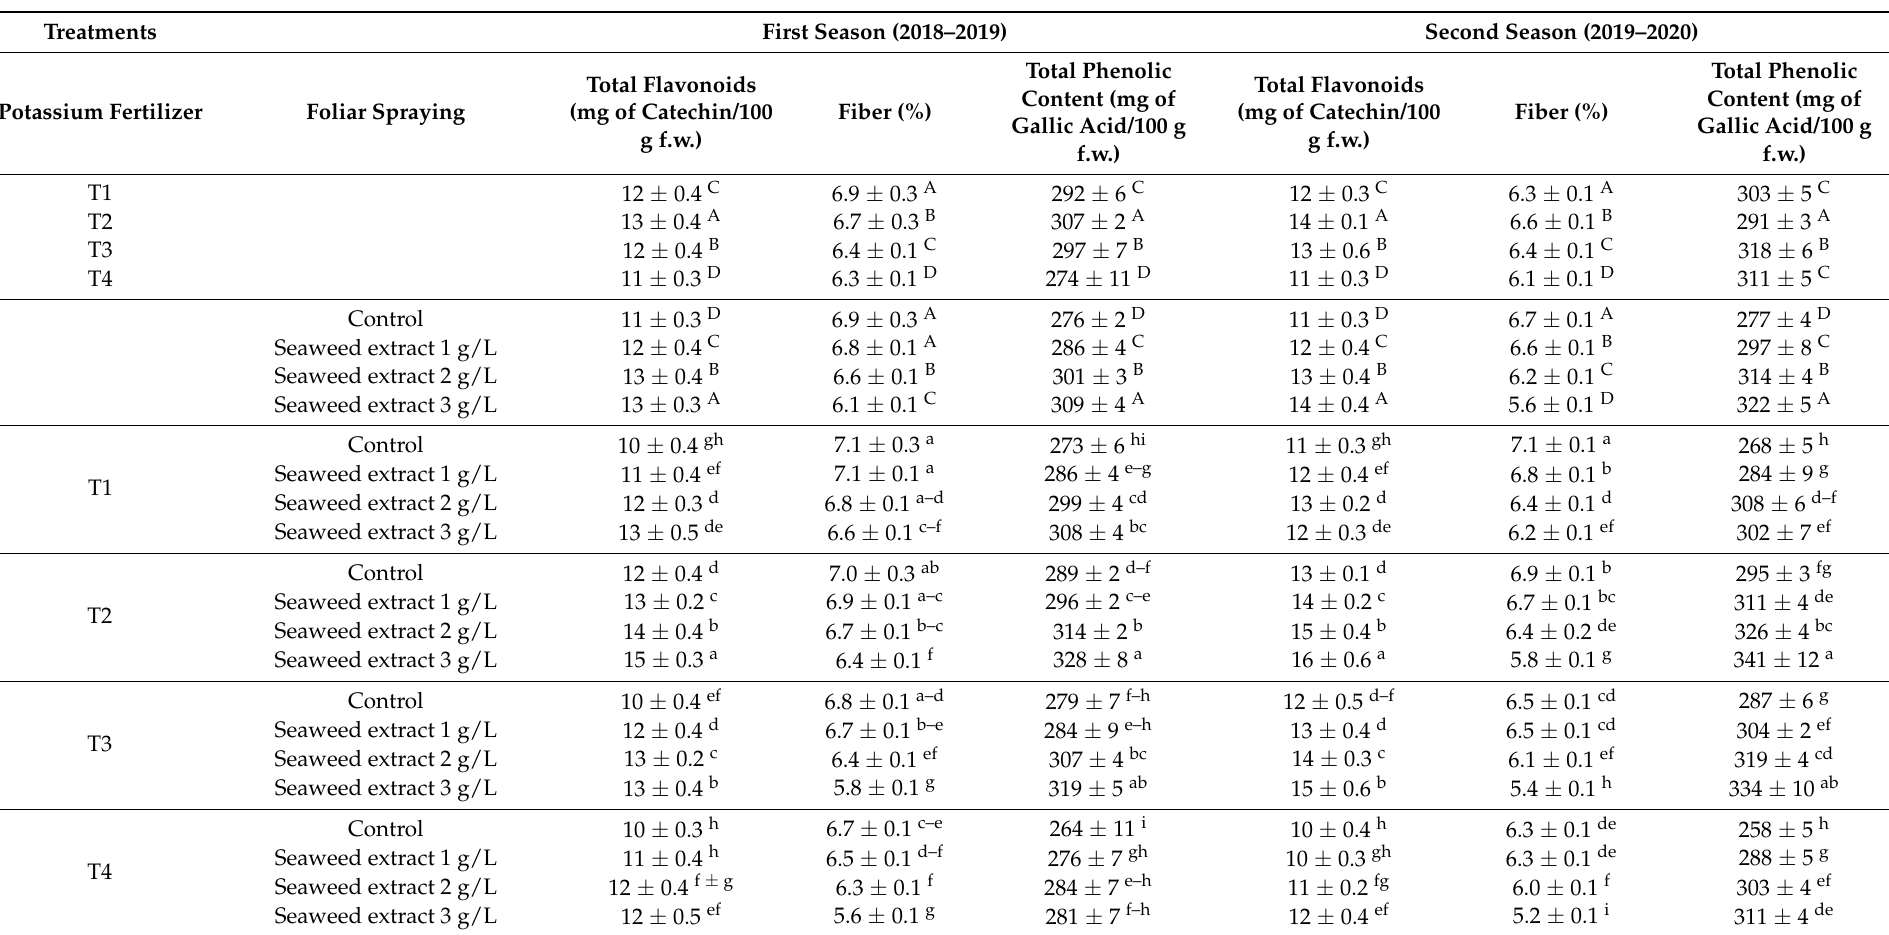
Table 9. The effect of potassium fertilizer, biofertilizer, and foliar spraying of seaweed extract on total flavonoids, total phenolic and fiber content of globe artichoke